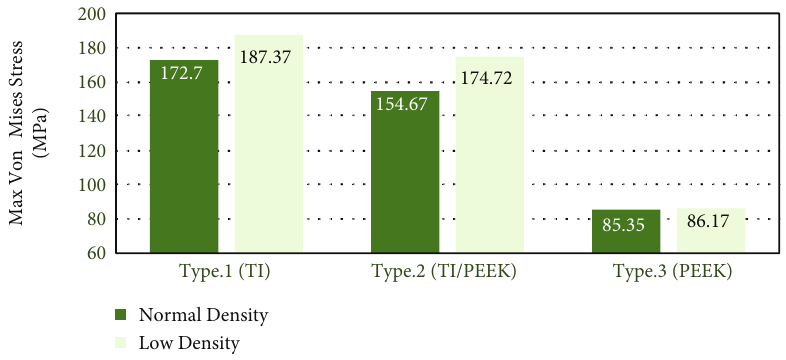
Figure 5: Maximum von Mises stresses (MPa) on